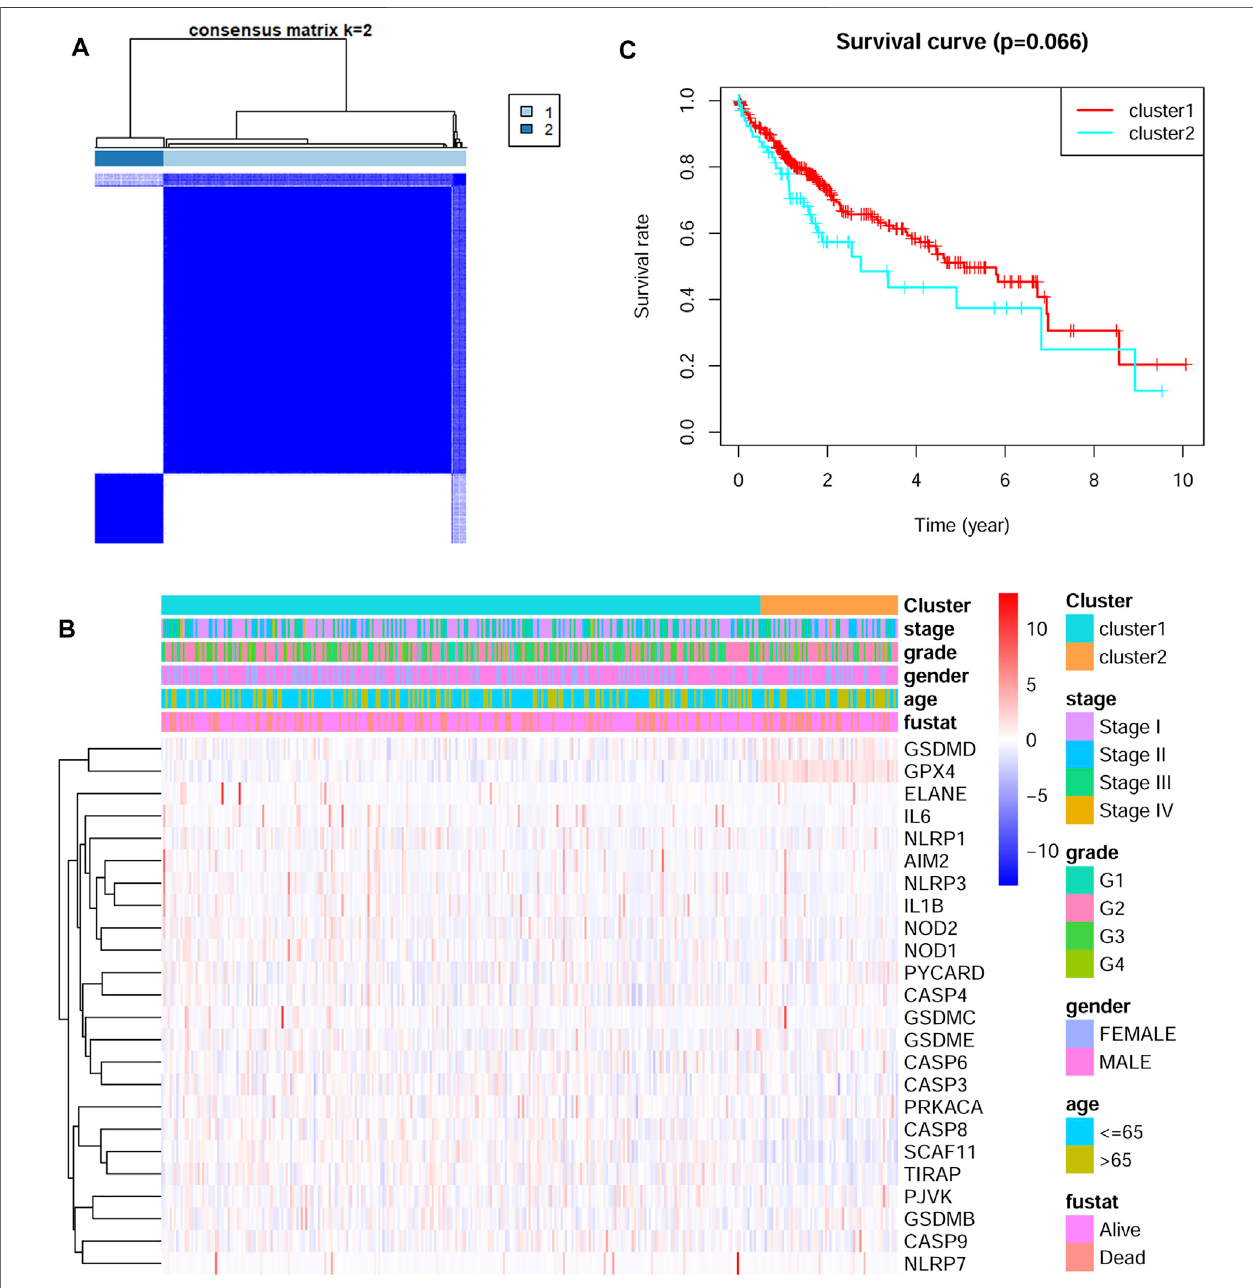
FIGURE2| Identi fi cation oftumor subtypes based onthe pyroptosis-related DEGs (A) Two clusterswere identi fi ed according tothe bestconsensus matrix(k (cid:1) 2) (B) The correlations between the pyroptosis-related DEGs and clinicopathologic characters of the two clusters were shown as a heatmap (C) The overall survival between the two